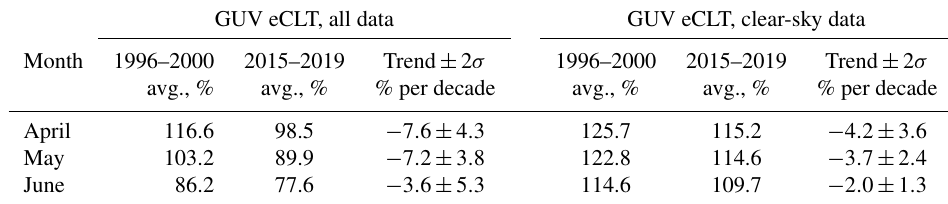
Table 7. Effective cloud transmittance (eCLT) in Ny-Ålesund for 1996–2019. “All data” represent monthly noontime average eCLT where all days are included. “Clear-sky data” represent monthly eCLT noontime average for days with eCLT > 100% and classified as clear from the NCCS cloud data. Uncertainty is expressed as 2 · SD (2 σ